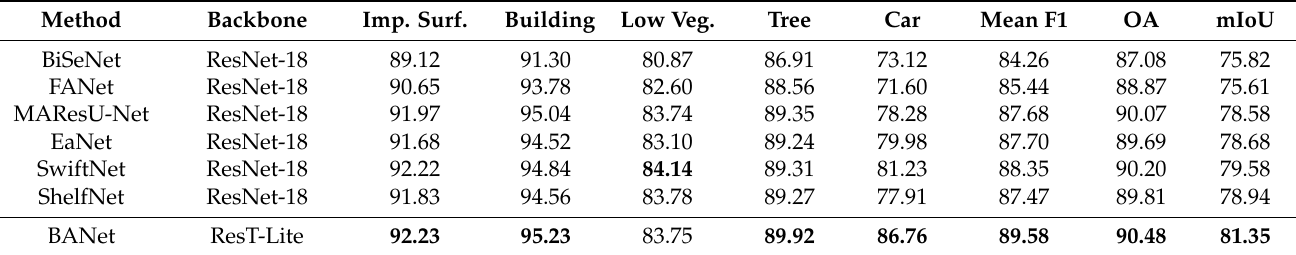
Table 1. The experimental results on the Vaihingen dataset.